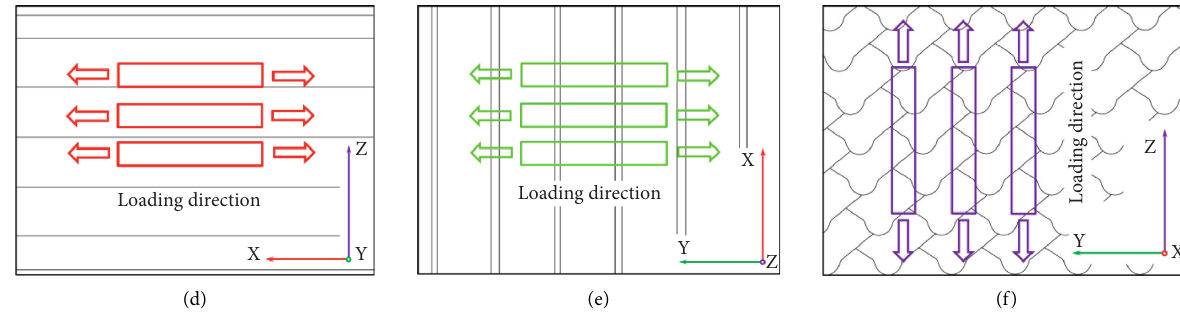
Figure 6: Microhardness distribution and schematic sampling locations of tensile test. (a) Test points distribution of microhardness; (b) microhardness distribution cloud map; (c) sampling locations of tensile test sample from a 3-D view; sampling locations of tensile test sample along (d) X , (e) Y , and (f) Z .